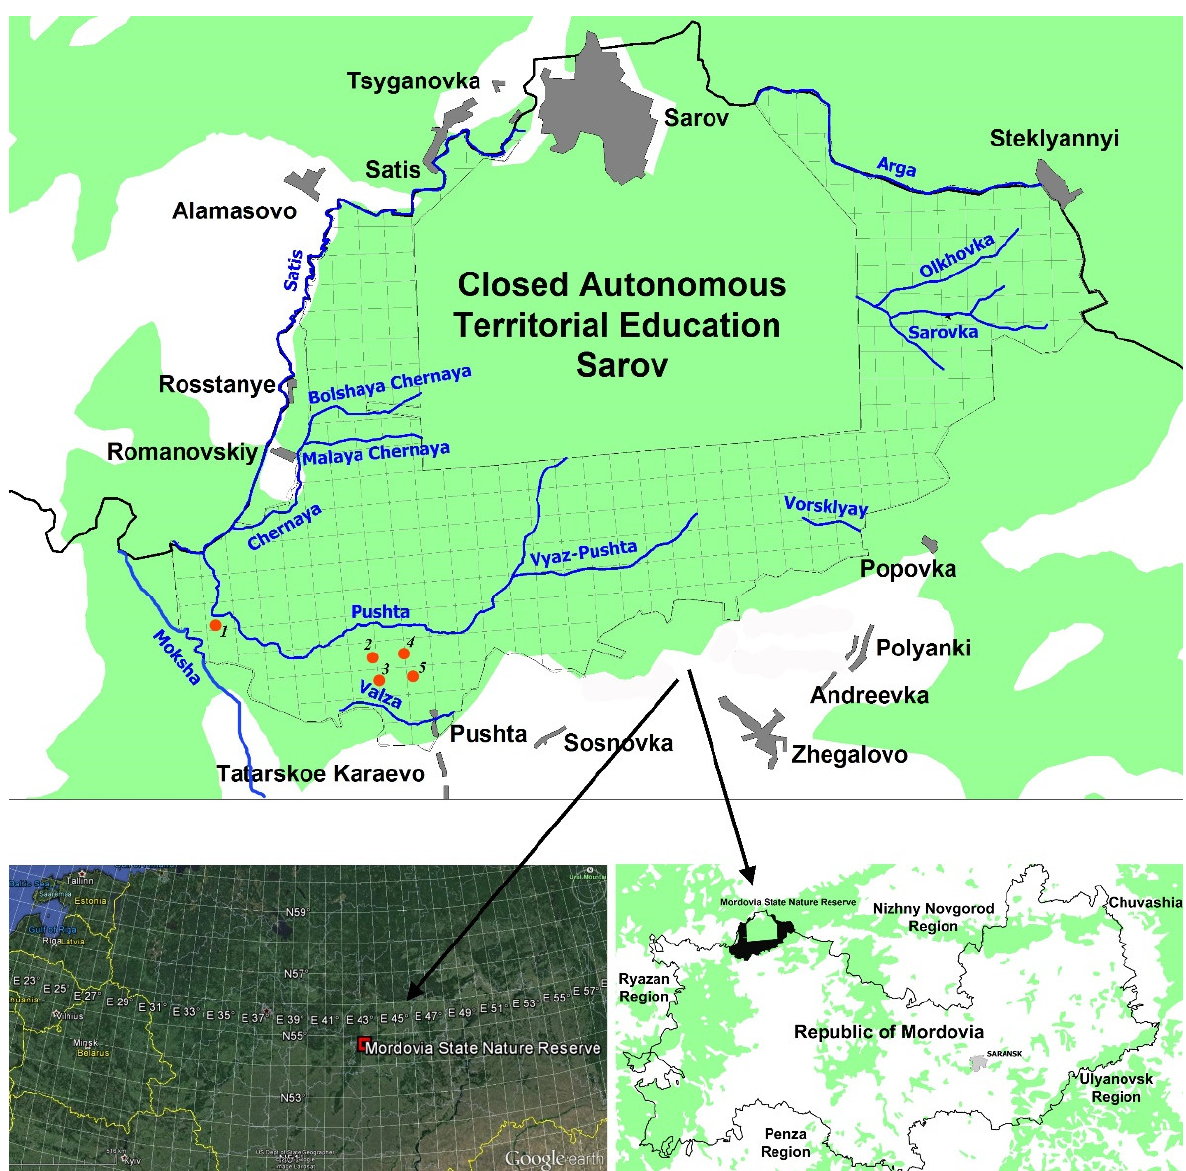
Figure 1. Geographical position of the Mordovia State Nature Reserve in Europe. The places of collection of the material (the studied areas) are indicated by numbers.